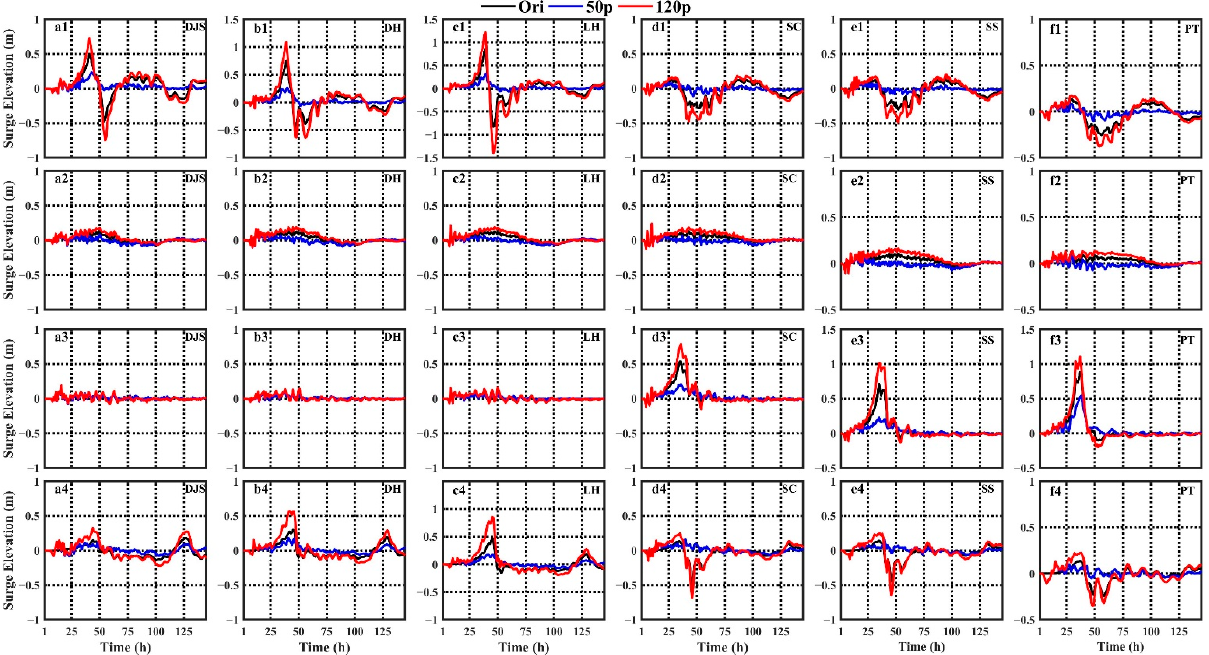
Figure 17. The time series of surge elevations in different wind intensity cases: ( a1 – f1 ) Chan-hom, ( a2 – f2 ) Mireille, ( a3 – f3 ) Herb, and ( a4 – f4 ) Winnie. Table 8. The model results of surge, fall, time, and the value of AI in different wind intensity dur- ing four paths at six stations. Surge (m): Surge max ; fall (m): Fall max ; time: occurrence time of surge reaches the peak (from a cold start); AI: asymmetry index.